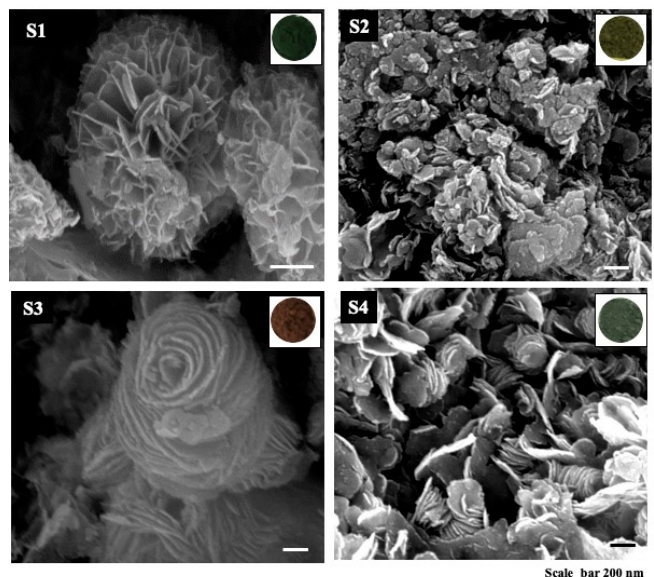
Figure 5. FE-SEM images of SnS 2 nanoparticles (S1–S4) prepared using the thermal decomposition approach in the absence and presence of capping agents. The inset shows the digital images of powder samples.